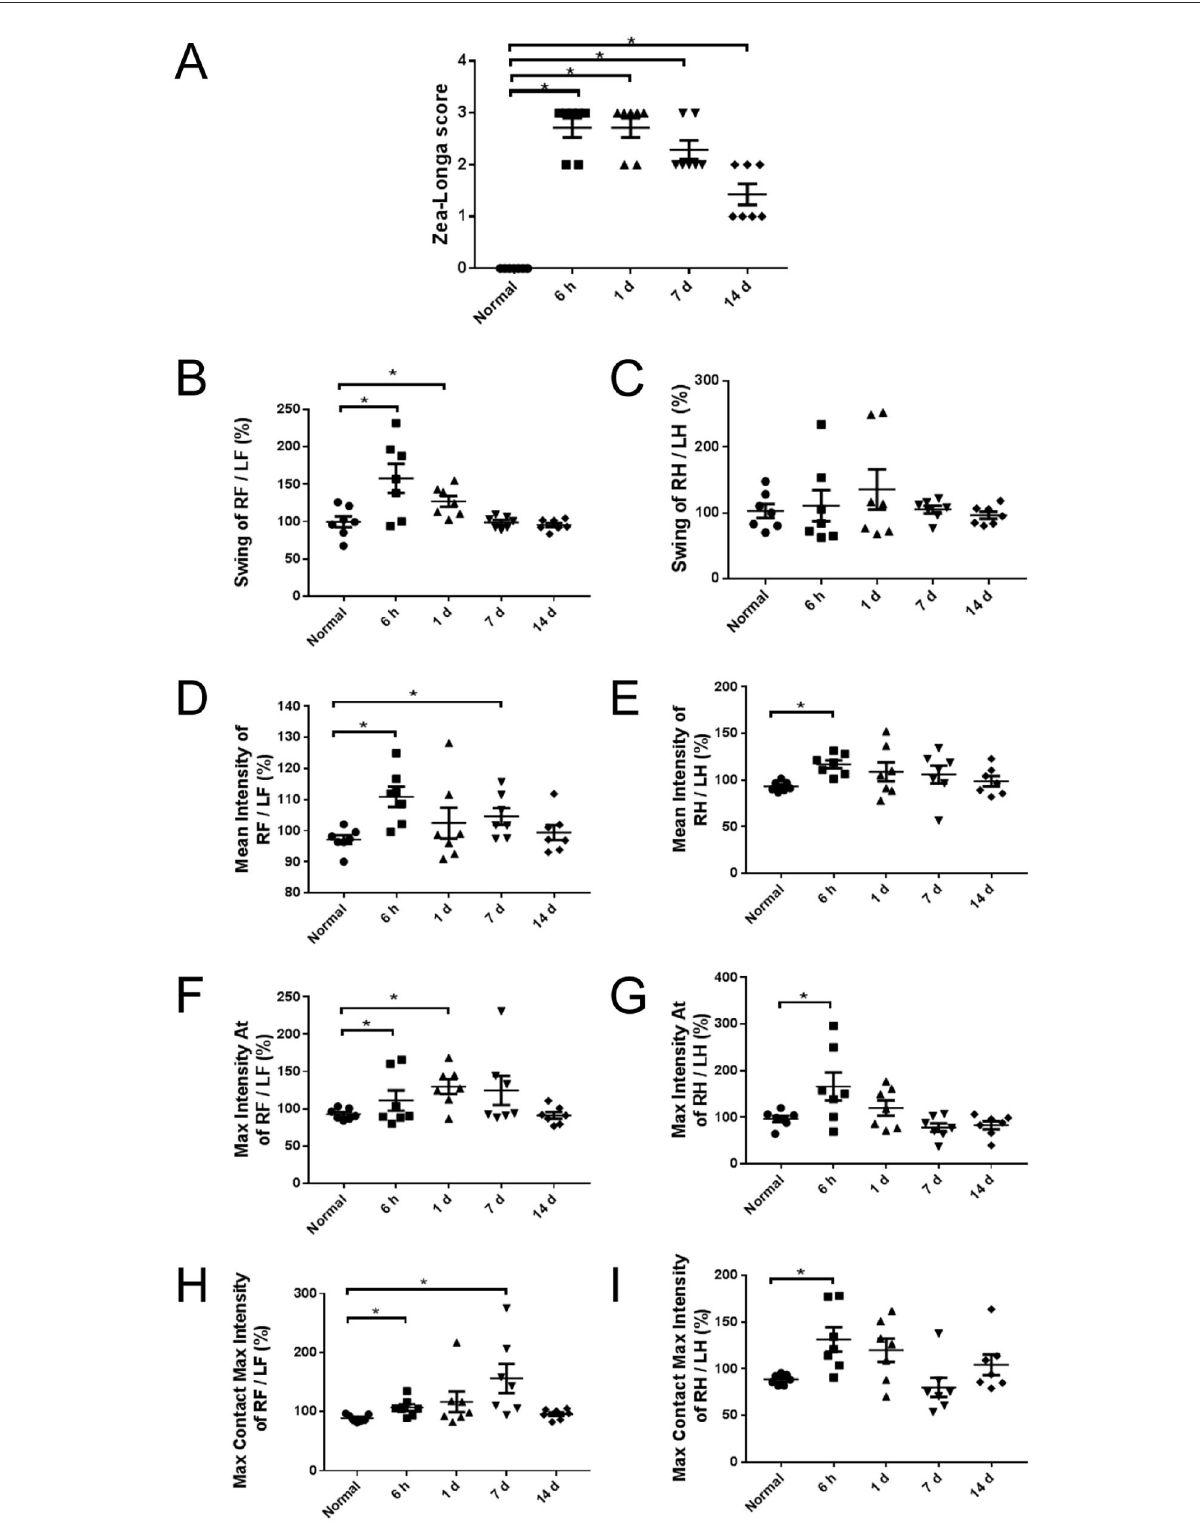
FIGURE1 Neurological deficit of rats at different time points. (A) Zea-Longa score in 6h, 1, 7, and 14 days groups increased significantly to normal group ( n = 7). (B–I) The Catwalk gait analysis of groups. The pattern of gait in forelimbs and hind limbs was not completely consistent.